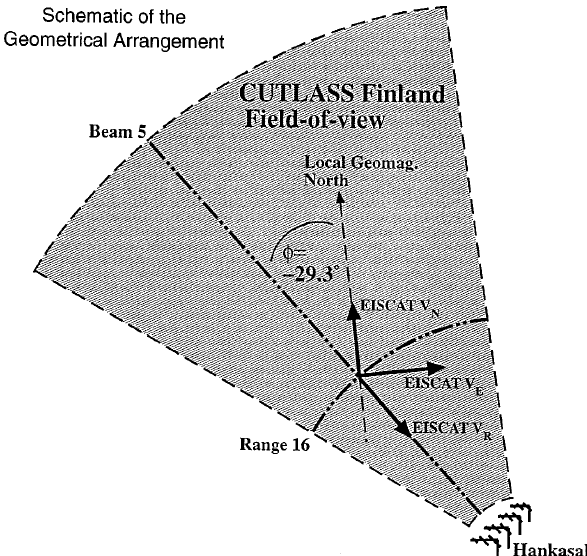
Fig. 1. Schematic diagram illustrating the geometrical arrangement for, as an example, CP-1 and the field-aligned position of CP-2. For field-aligned antenna pointing, the tristatic volume of the EISCAT UF radar is coincident with range gate 16 of beam 5 in the Finland radar field-of-view and in this range cell the CUTLASS beam direction is some 29.3 (cid:176) counter clockwise of local geomagnetic north (see Table 1). V and V indicate the components of the tristatic ion N E velocity measured by EISCAT in the field-perpendicular northward and eastward direction, respectively. V indicates the component of R the EISCAT velocity resolved along direction of the CUTLASS beam, in this case within range gate 16 of beam 5, calculated using the expression shown in